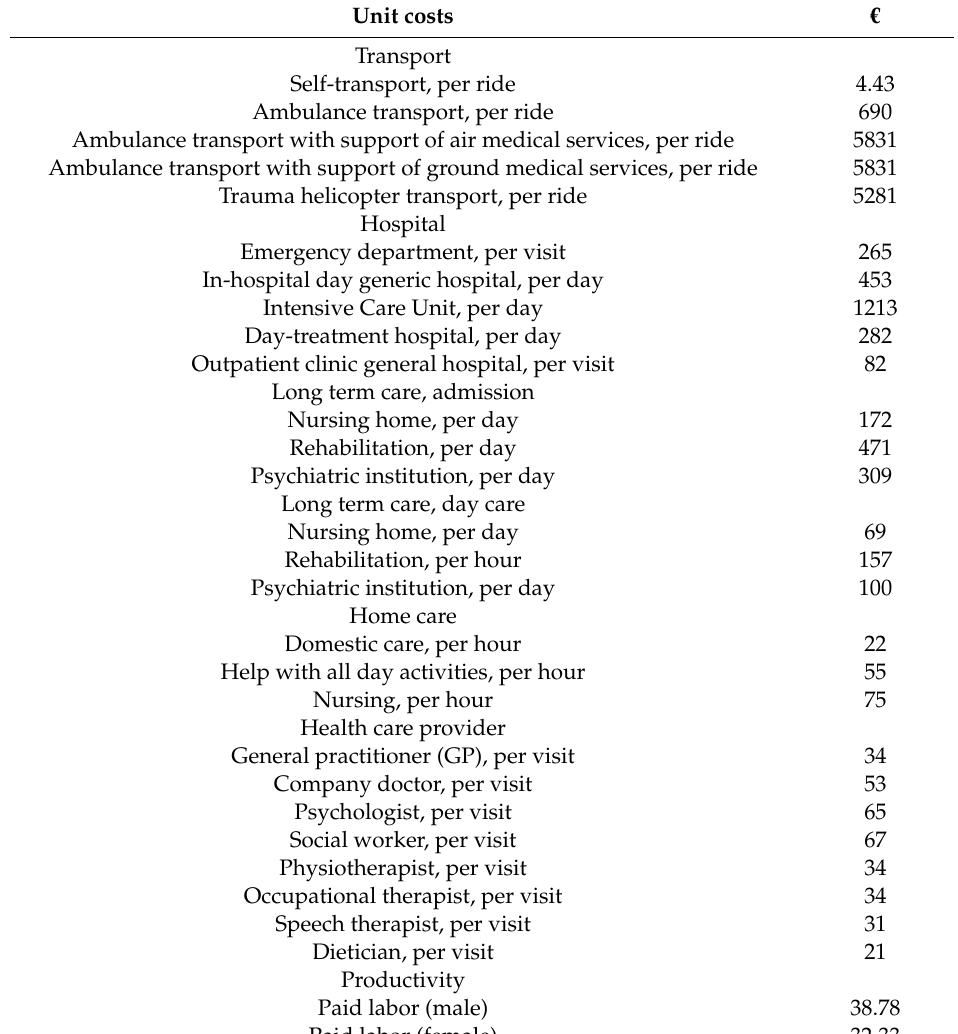
Table A1. Unit Costs (2017 € ).